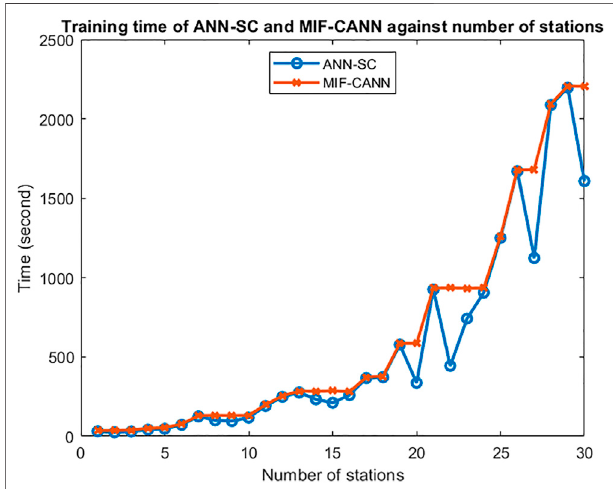
FIGURE 6 | The training time of ANN-SC and MIF-CANN against the number of stations.